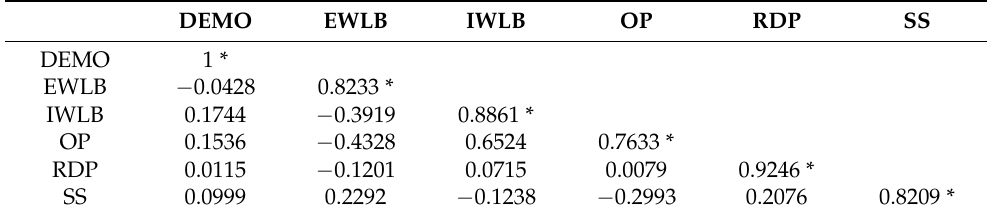
Table 5. Fornell and Larcker’s